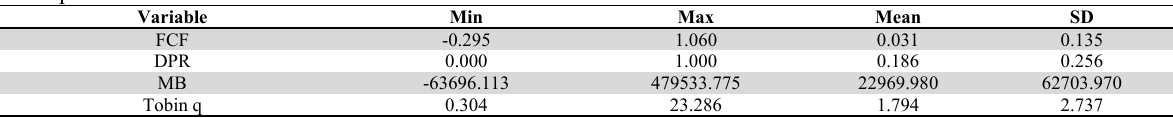
Descriptive Data from Research Variables